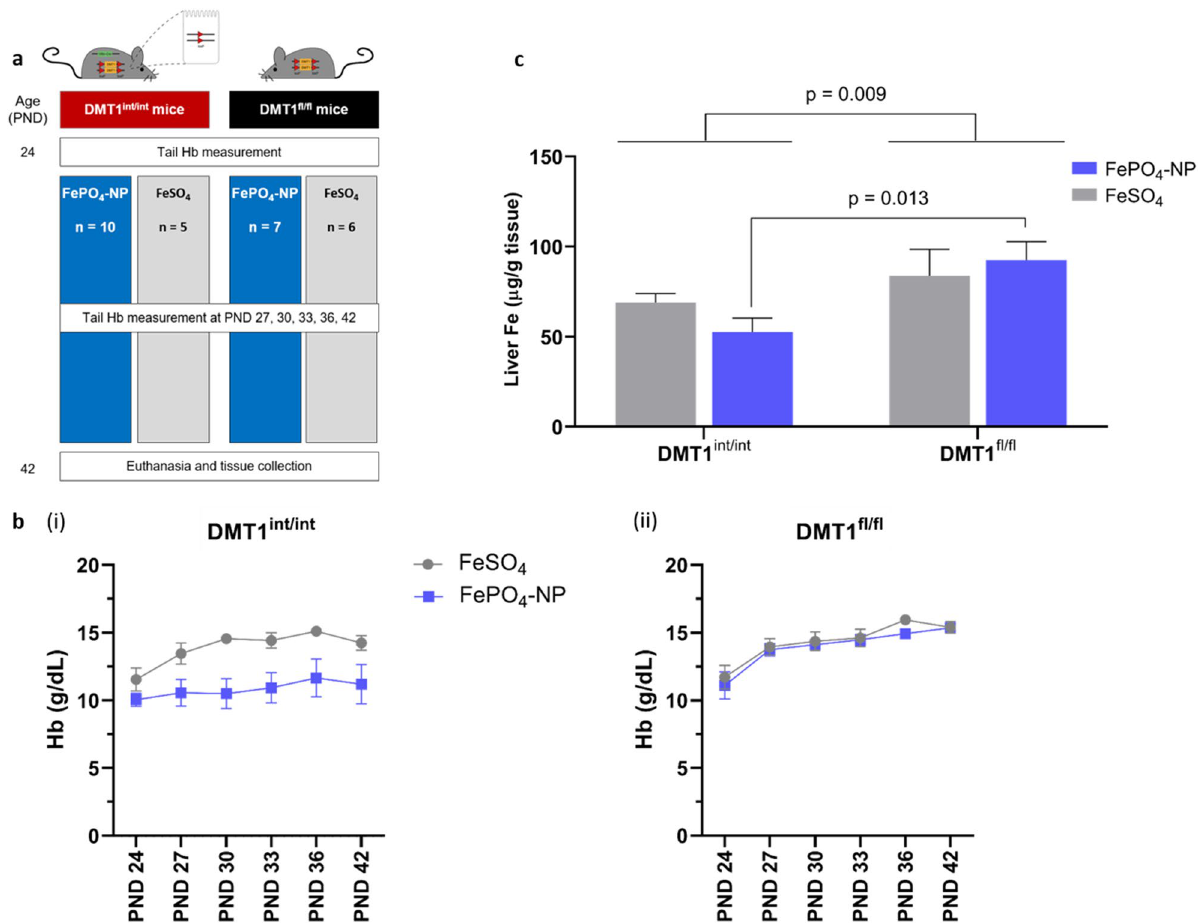
Figure 3. Eighteen-day feeding study in DMT1 int/int and DMT1 fl/fl mice. (a) Outline of feeding study. ( b) Hemoglobin (Hb) trajectory in (i) DMT1 int/int (n = 6 male; n = 9 female) and (ii) DMT1 fl/fl (n = 6 male; n = 7 female) mice receiving the AIN93G diet fortified with FePO 4 -NP (SSA 98 m 2 g −1 ) or FeSO 4 (reference compound). Results are shown as means ± SEM. ( c) Liver iron concentrations in DMT1 int/int and DMT1 fl/fl mice fed diets fortified with 35 ppm FeSO 4 or FePO 4 -NP for 18 days (postnatal days [PND] 24 ‒ 42). Differences in liver iron concentrations by genotype (DMT1 int/int vs. DMT1 fl/fl ) and by iron compound (FePO 4 -NP vs. FeSO 4 ) were determined by two-sided independent t-tests. The results are shown as means ± SEM and differences were considered significant at p < Absorption and biodistribution of radiolabeled FePO -NP and FeSO from a single oral dose in 4 4 iron deficient anemic DMT1 int/int and DMT1 fl/fl mice. To determine whether absorption of FePO 4 -NP is DMT1-dependent and biodistribution comparable to FeSO 4 in iron deficient anemic conditions, we adminis- tered a single oral dose of irradiated FePO 4 -NP (SSA 98 m 2 g −1 ) or FeSO 4 labelled with radioactive iron ( 59 Fe) to iron deficient anemic DMT1 int/int and DMT1 fl/fl control mice and measured tissue distribution of 59 Fe 24 h after administration. Based on the findings from the feeding study, we hypothesized that less iron from a single oral dose of FePO